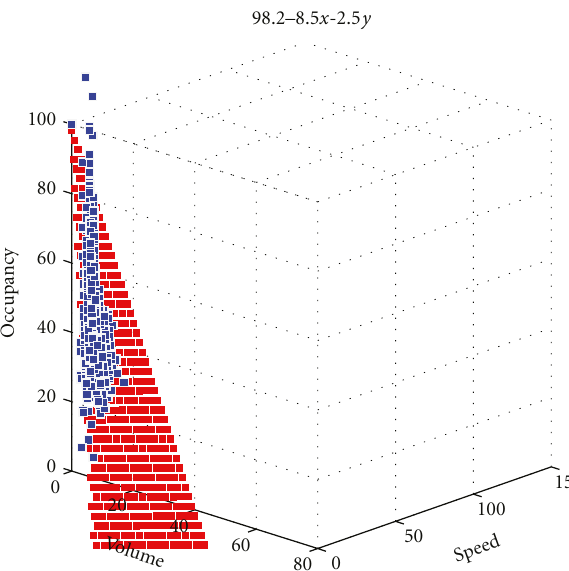
Figure 7: Regression plane (red) for Congested tra ffi c.